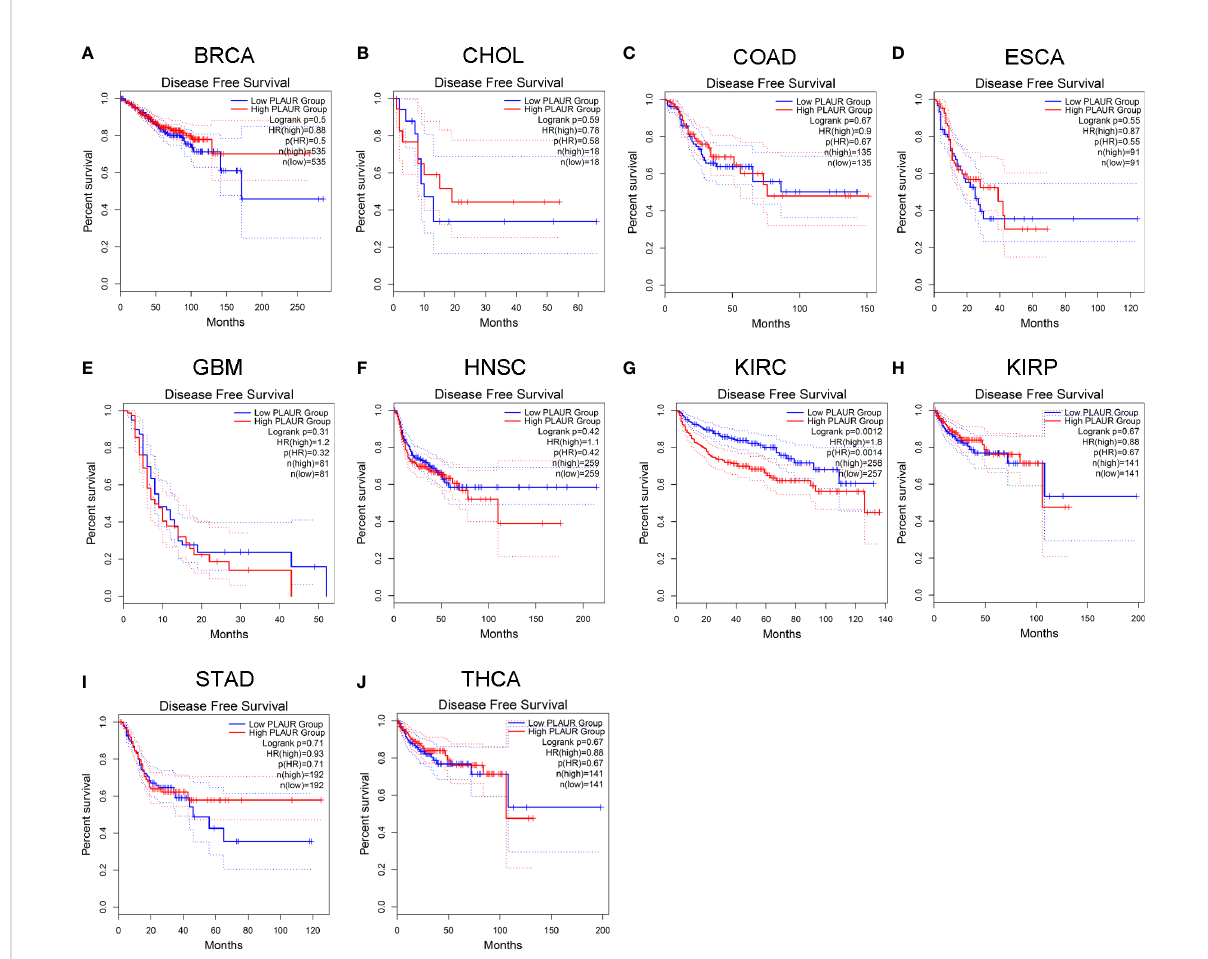
FIGURE 3 Kaplan-Meier survival curve for DFS in 10 different tumor types using the GEPIA database. (A – J) BRCA, CHOL, COAD, ESCA, GBM, HNSC, KIRC, KIRP, STAD,